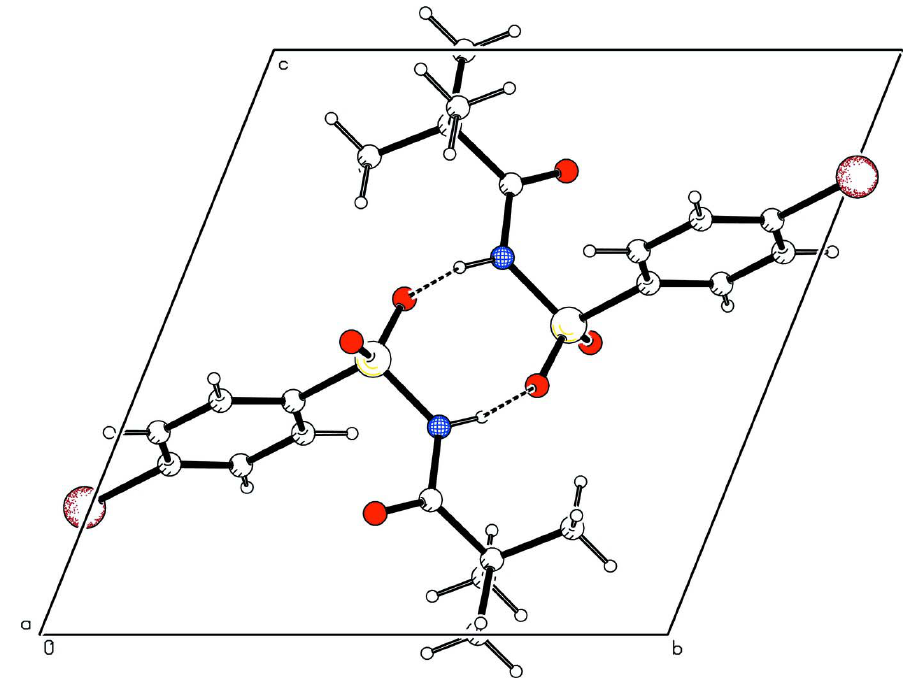
Figure 2 Molecular packing of the title compound with hydrogen bonding shown as dashed